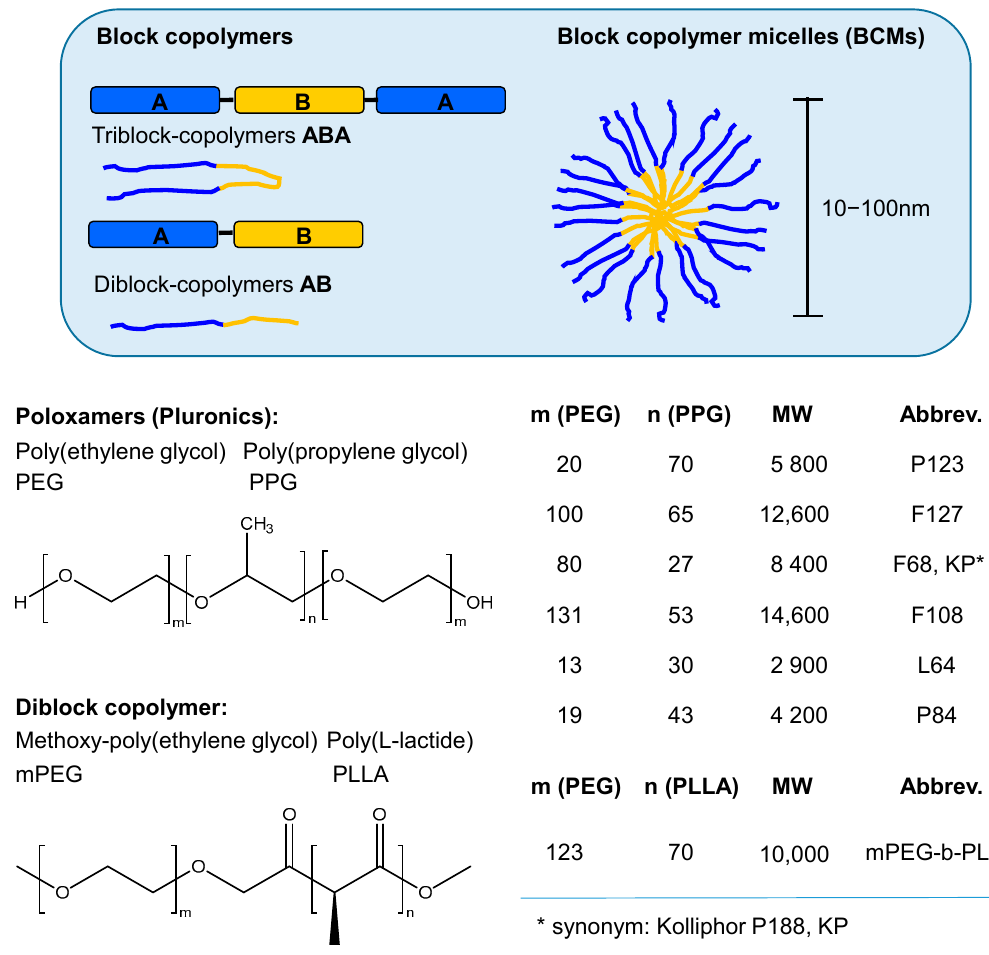
Figure 11. Structures of block copolymers forming micelles discussed in the current review.